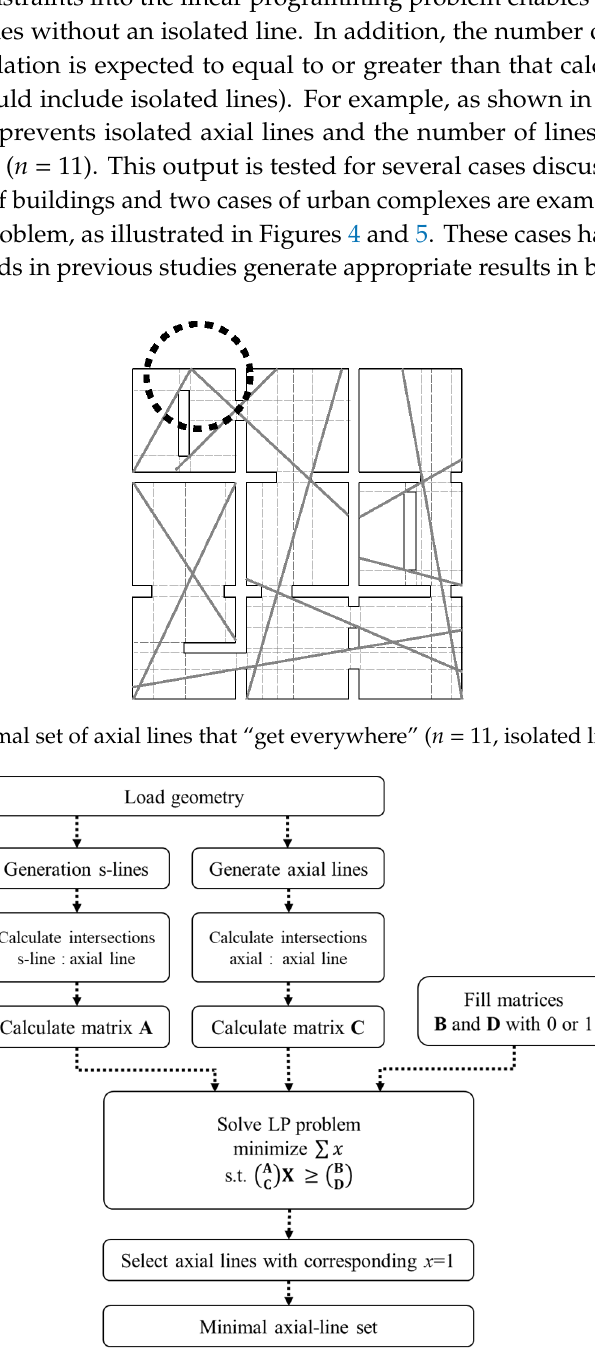
Figure 4. Computation procedure of the modified problem.